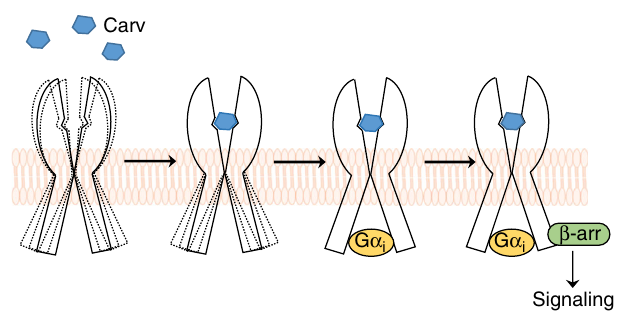
Fig. 9 Schematic model of the carvedilol-induced G α i - β -arrestin-biased signaling of β 1 ARs. Binding of carvedilol to the orthosteric site of the β 1 AR stablizes a distinct intermediate conformation that then promotes the recruitment of G α i . The carvedilol- and G α i -bound receptor in turn